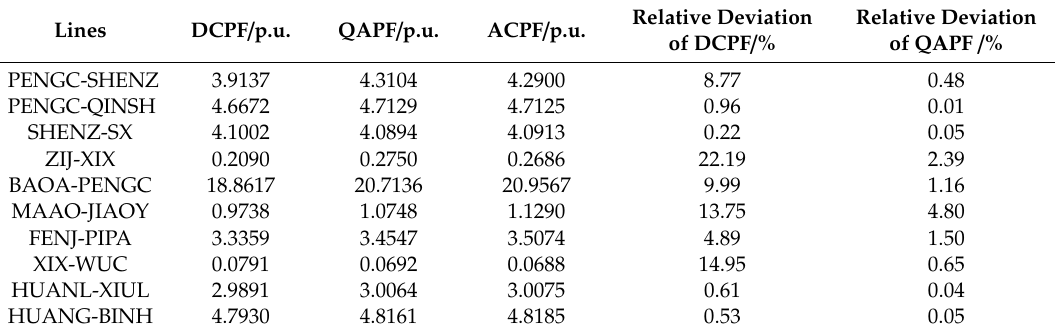
Table 11. Comparison of the active power of several lines computed by di ff erent PF models.